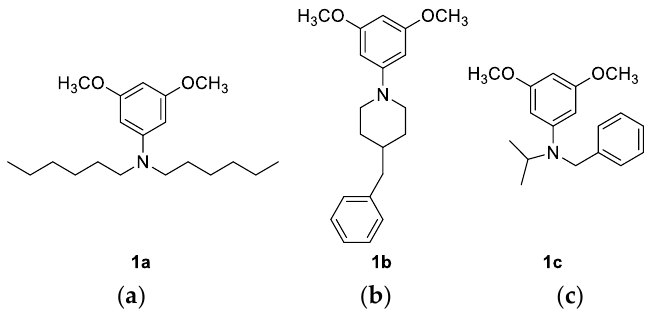
Figure 2. Structures of the derived products: ( a ) N , N -dihexyl-3,5-dimethoxyaniline ( 1a ): 45%; 1 H Figure